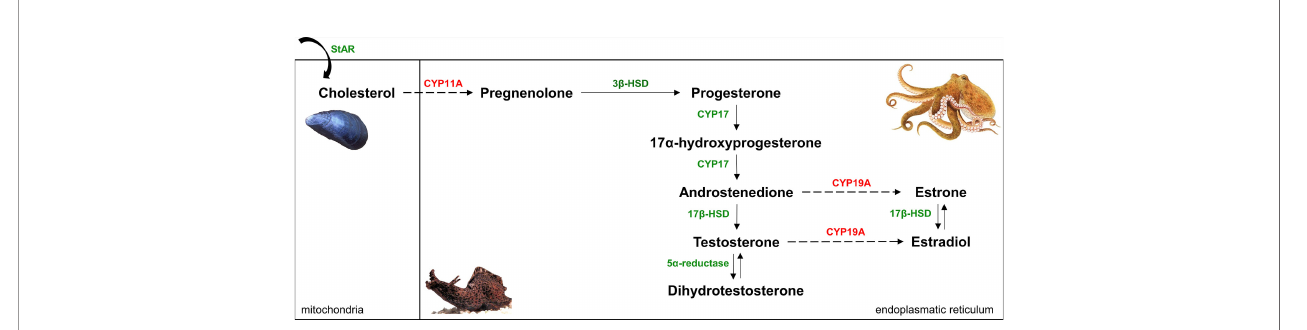
FIGURE 1 | Simpli fi ed ( ‘ delta-5-steroids ’ formed from pregnenolone are not shown) vertebrate sex steroidogenesis pathway [modi fi ed after (19)]. Six reactions (solid arrows), though some with low activity, and the enzymes that catalyze (indicated by green color) them appear to be present in mollusks. CYP11A and CYP19A (marked by red color) have not been found in molluscan genomes so far, this supports the notion that two crucial steps - cholesterol side-chain cleavage and aromatization (dashed arrows) - of the classical vertebrate steroid biosynthetic pathway are absent